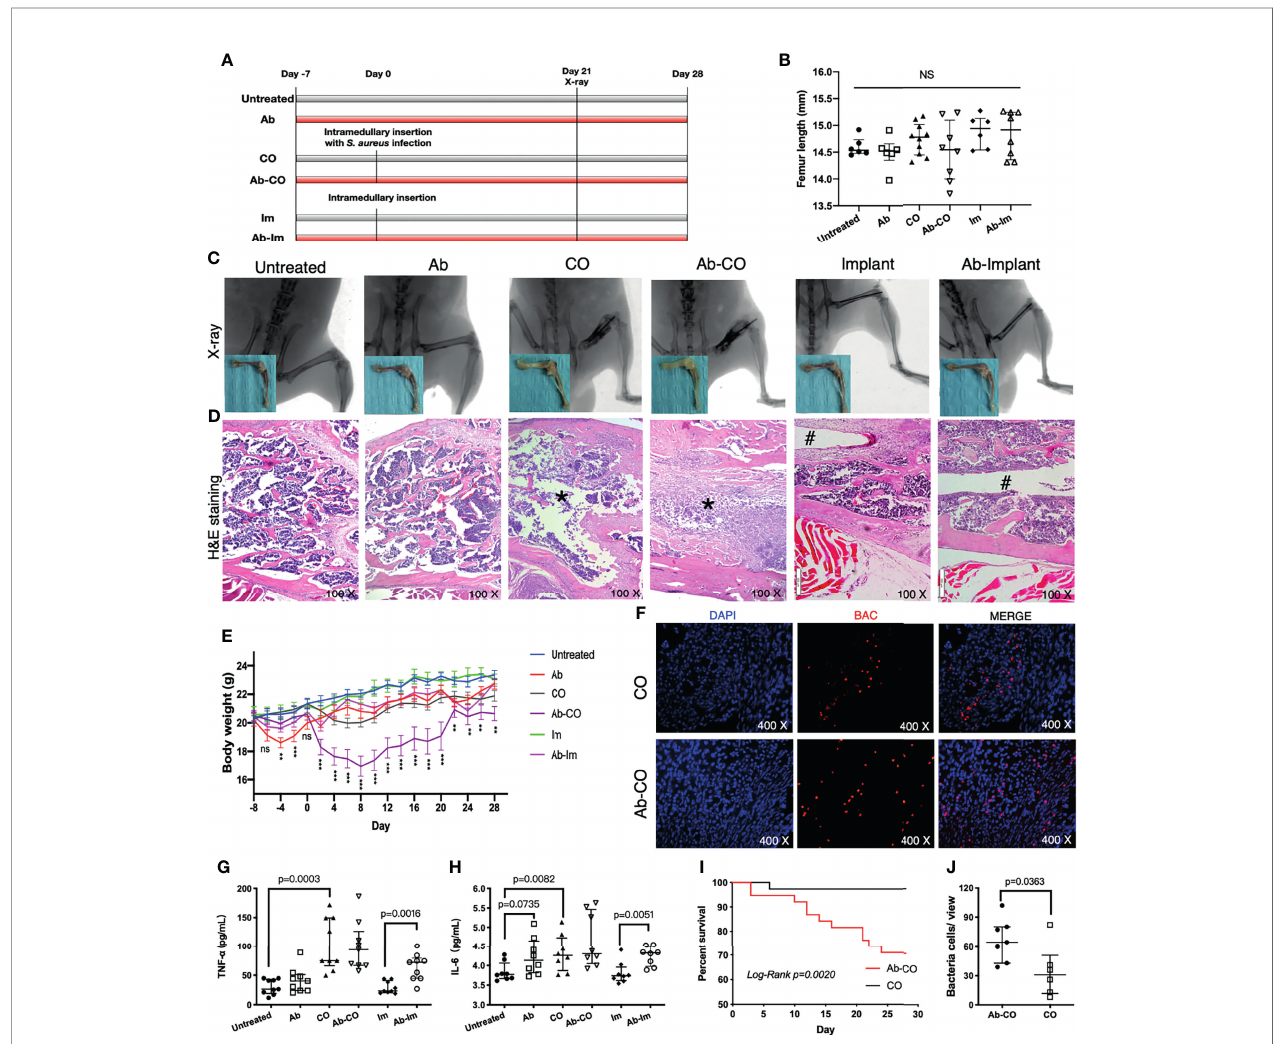
FIGURE 1 | Perturbation of gut microbiota impaired host resistance to chronic osteomyelitis and enhanced proin fl ammatory response. Specimens were harvested at 4 weeks postsurgery from mice in untreated, antibiotic-treated (Ab), chronic osteomyelitis (CO), antibiotic-treated CO (Ab-CO), implant (Im), and antibiotic-treated implant (Ab-Im) groups. (A) Experimental fl ow chart. (B) Length of femur specimen. (C) X-ray images of the femur in lateral view and gross photos after soft tissue dissection. (D) Histological analysis of the distal femur by H&E staining, osteomyelitis signs (*) in CO and Ab-CO groups, and nail path (#) in Im and Ab-Im groups. (E) Body weights of mice in all groups. (F) Detection of S. aureus in distal femur specimens by FISH. The red signal represents S. aureus ; the blue signal represents eukaryotic cell nucleus. (G) Serum level of TNF- a in all groups (n=9). (H) Serum level of IL-6 in all groups (n=9). (I) Survival rates for CO and Ab-CO groups (n=38). (J) Bacterial cell counts based on FISH results from mice in CO and Ab-CO groups (n=5). Data for body weight, cytokines and bacterial cell counts are shown as the median and interquartile range. Survival data were analyzed using the log-rank test. Body weight data were analyzed by one-way ANOVA. “ NS ” for